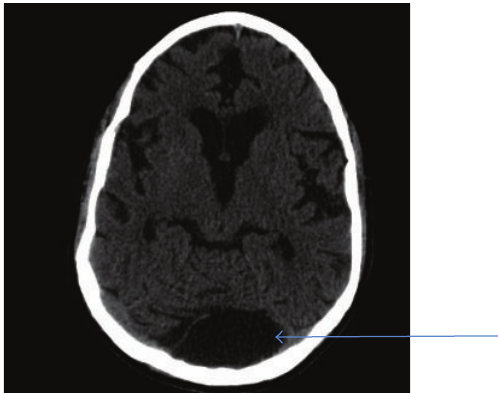
Figure 5: CT of the head without contrast. The ventricles and sulci are prominent, most consistent with global cerebral volume loss. Hypoattenuation of the periventricular white matter is most consistent with chronic small vessel ischemic disease. There is no evidence for intraparenchymal mass lesion or hemorrhage. A large CSF-density space (blue line) is seen posterior to the midline cerebellum, measuring 5.0 × 2.9 cm in image 29 of series 2, most consistent with arachnoid cyst. The gray-white junction is intact. Mild polypoid mucosal thickening is seen within the left maxillary sinus. Mild mucosal thickening is also seen within the right sphenoid sinus. A large right mastoid effusion is